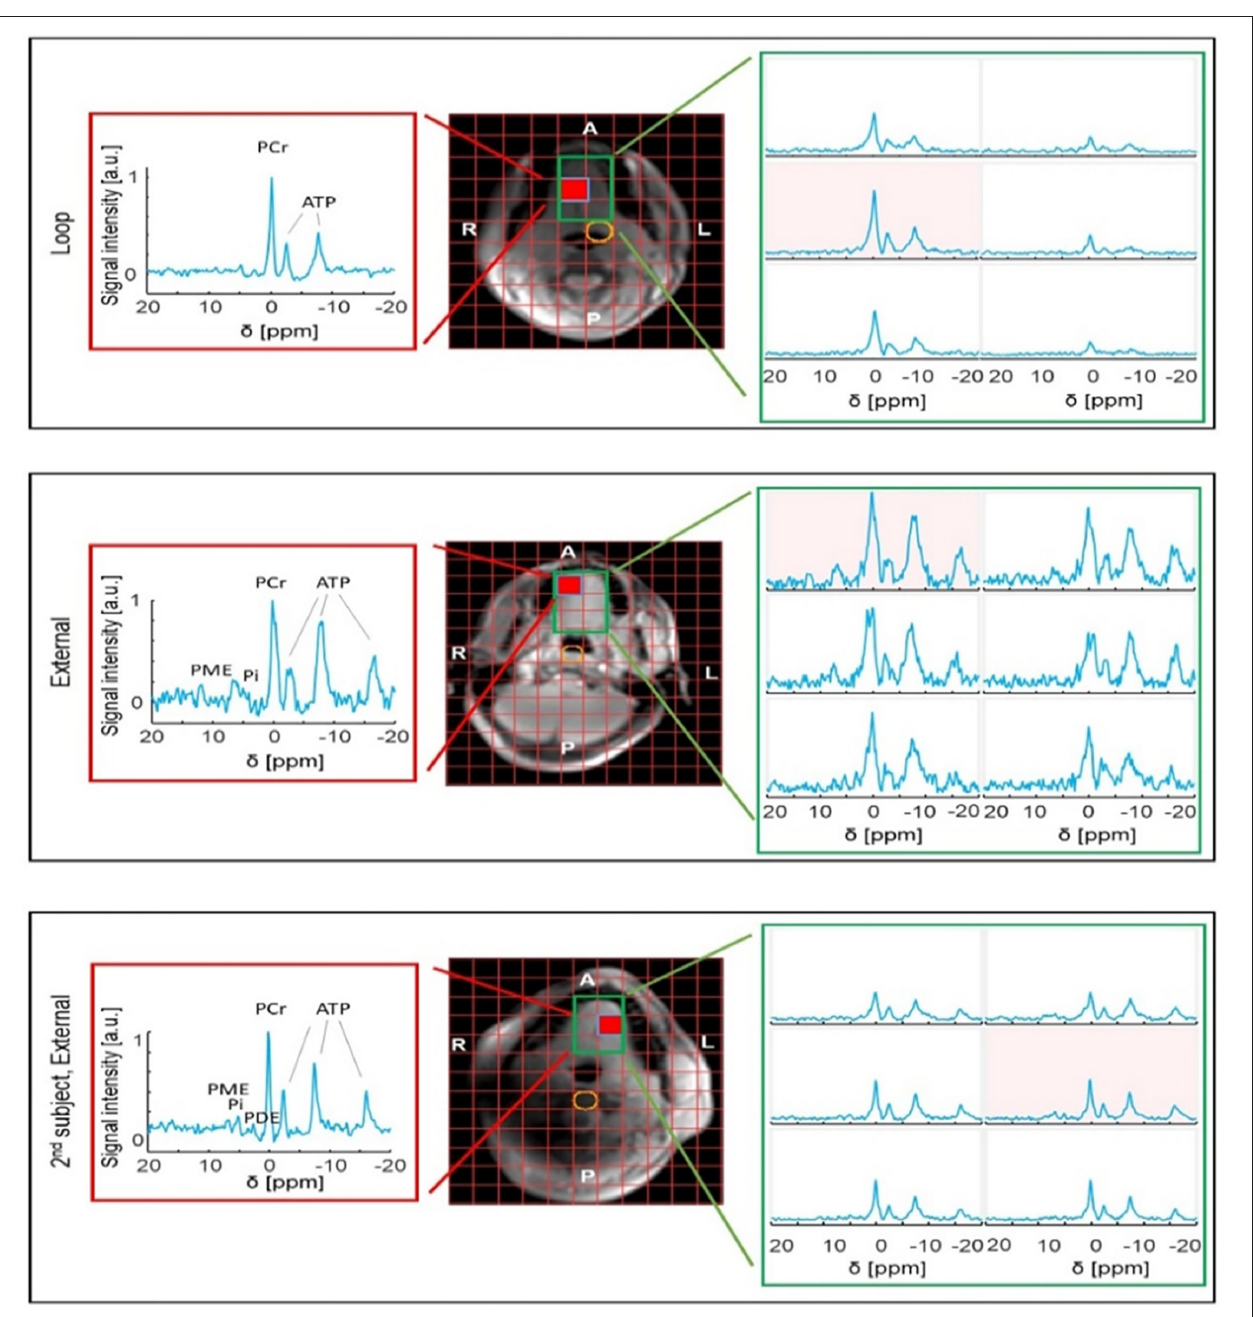
FIGURE 3 | 31 P MRSI results obtained from the tongue of healthy volunteers using either the internal loop coil (central voxel position marked in yellow) (top) or external array (middle and bottom). Note that the SNR is substantially variable between subjects. The red voxel shows the best-case SNR for the slice. The variable proton signal is due to the short wavelength of 1 H at 7T in water